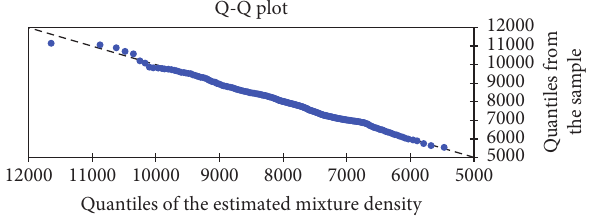
Figure 5: The quintiles of the estimated mixture density. Table 5: The proportions of three components.